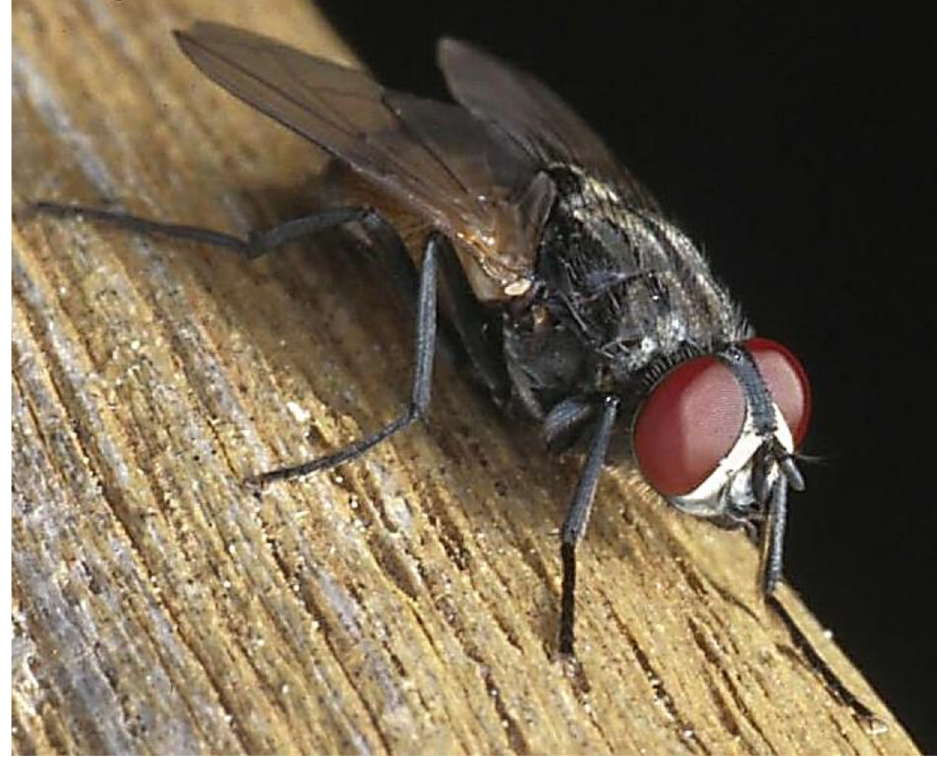
Figure 1. House flies are morphologically, physiologically, and behaviorally suited to serve as disease vectors.